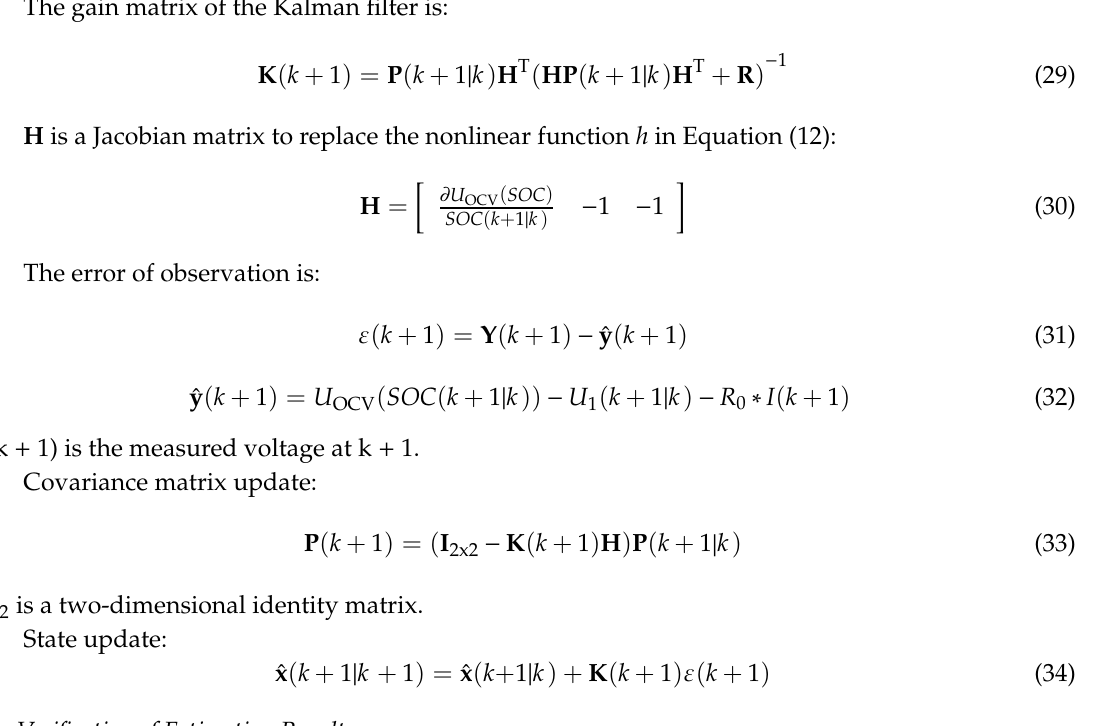
Figure 18. Comparison of SOC errors between FEKF and EKF under 26 continuous DST conditions at 28 °C.